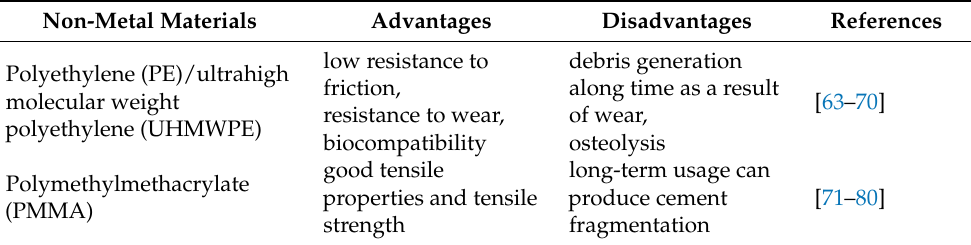
Table 2. Advantages and disadvantages of some non-metal materials used in orthopedics. Non-Metal